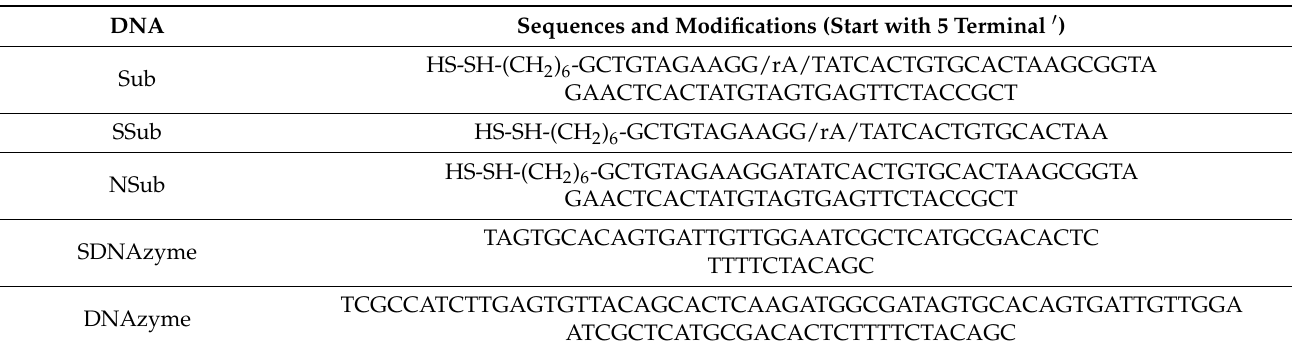
Table 1. The modified DNA sequences. DNA Sequences and Modifications (Start with 5 Terminal (cid:48)